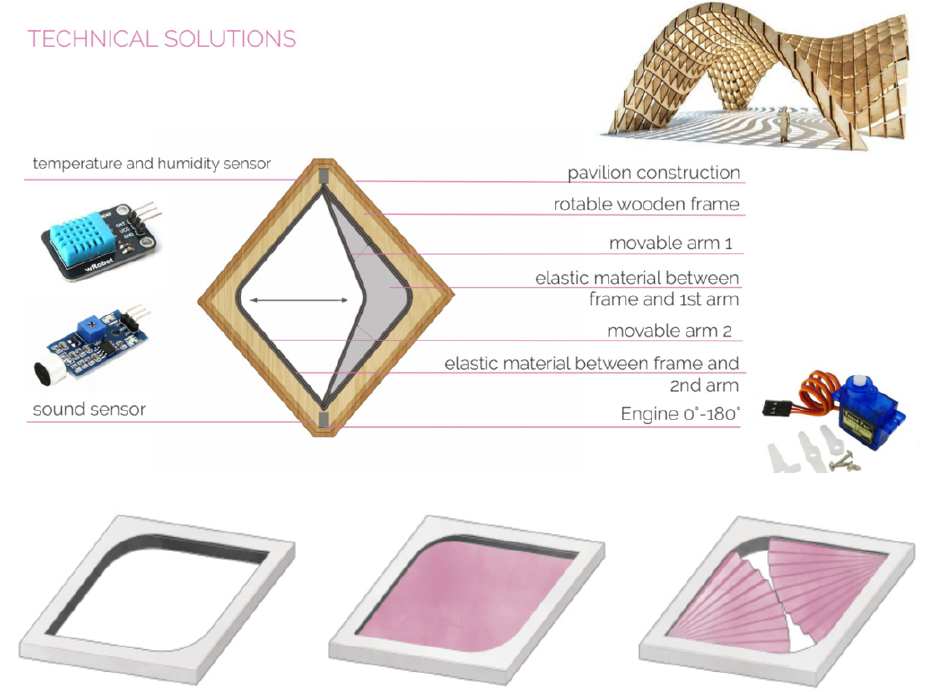
Figure 7. Kinetic panels of Snap Hub.